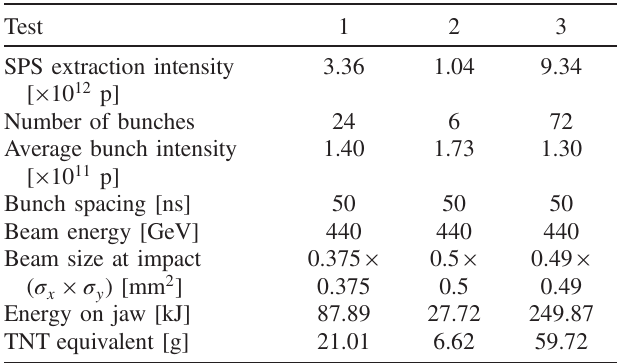
TABLE V. Summary of the test parameters.